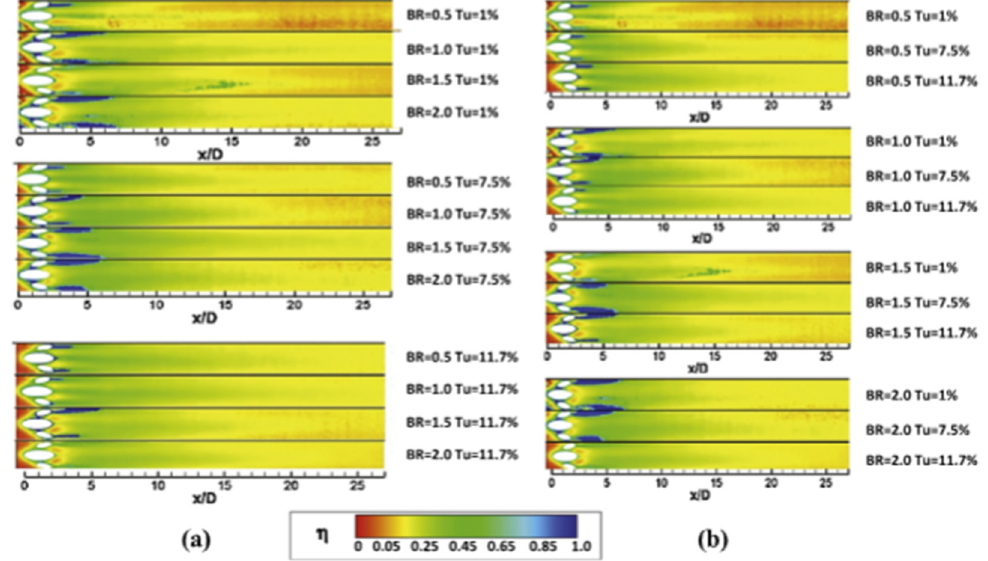
Figure 10. Local adiabatic film cooling effectiveness measured by a transient LC technique [96], ( a ) h , ( b ) η . Reprinted with permission: License number 5177211004715.